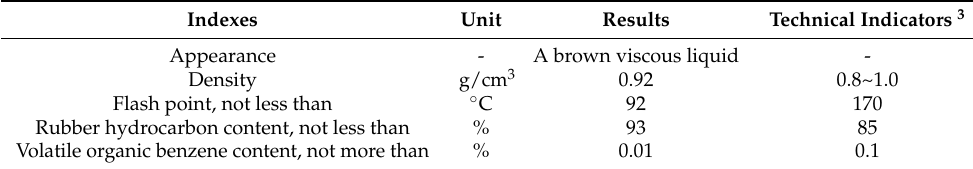
Table 3. Technical indexes of styreneic methyl copolymers (SMCs)